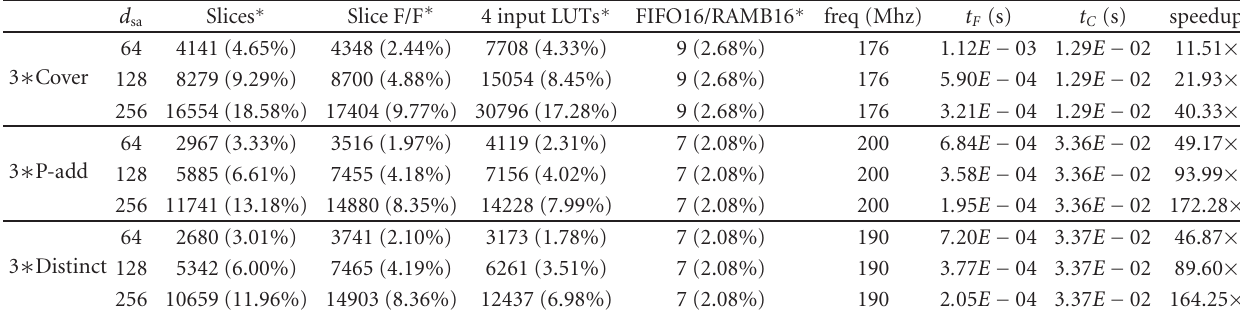
Table 4: Experimental results for subtask